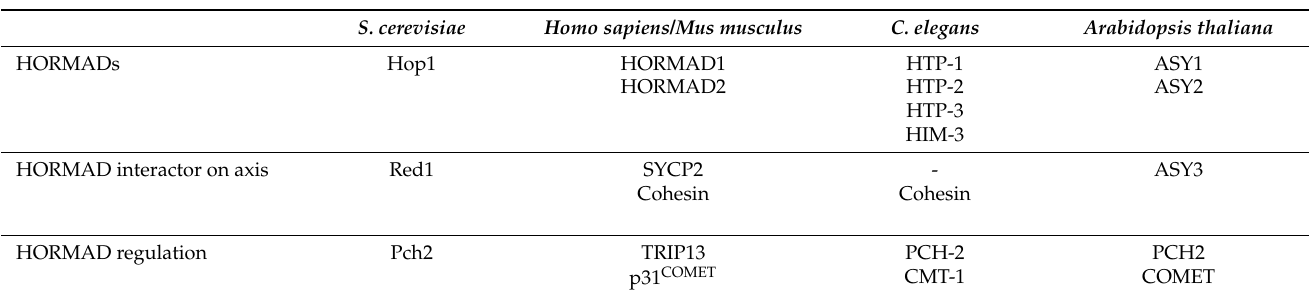
Table 1. Orthologues of meiotic HORMADs, their main axis interactors, and their regulators in yeast, mammals, worms, and